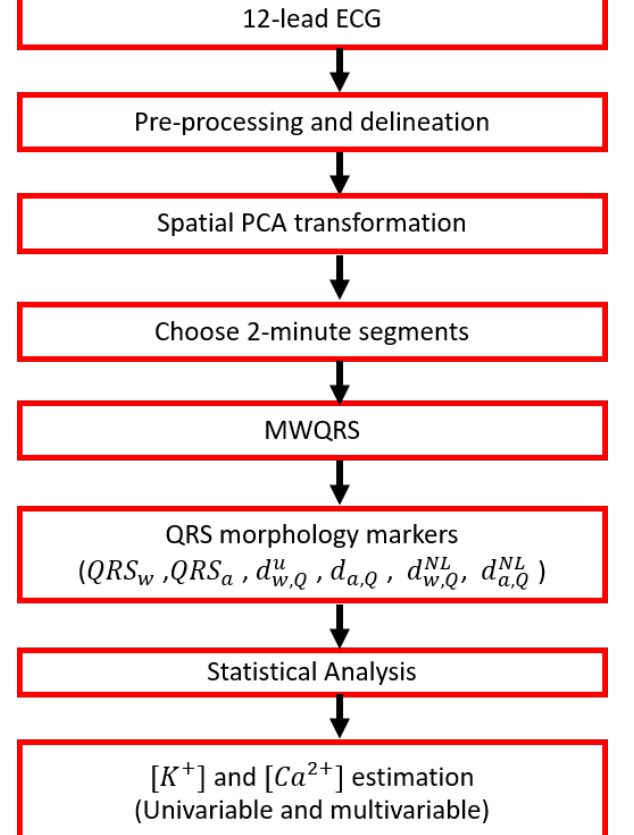
Figure 2. Flow chart showing the ECG processing steps performed in this study, from the collection of raw ECGs to the estimation of [ K + ] and [ Ca 2 + ]